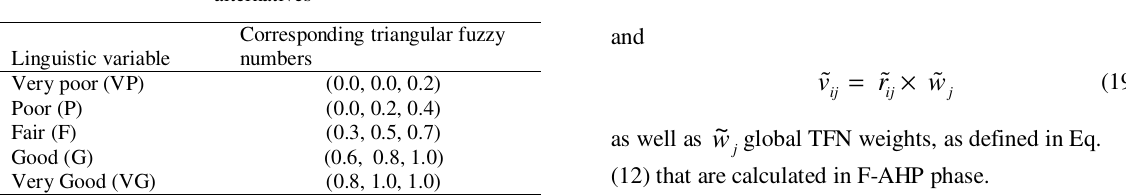
Table 3 Linguistic variables for the preference rating